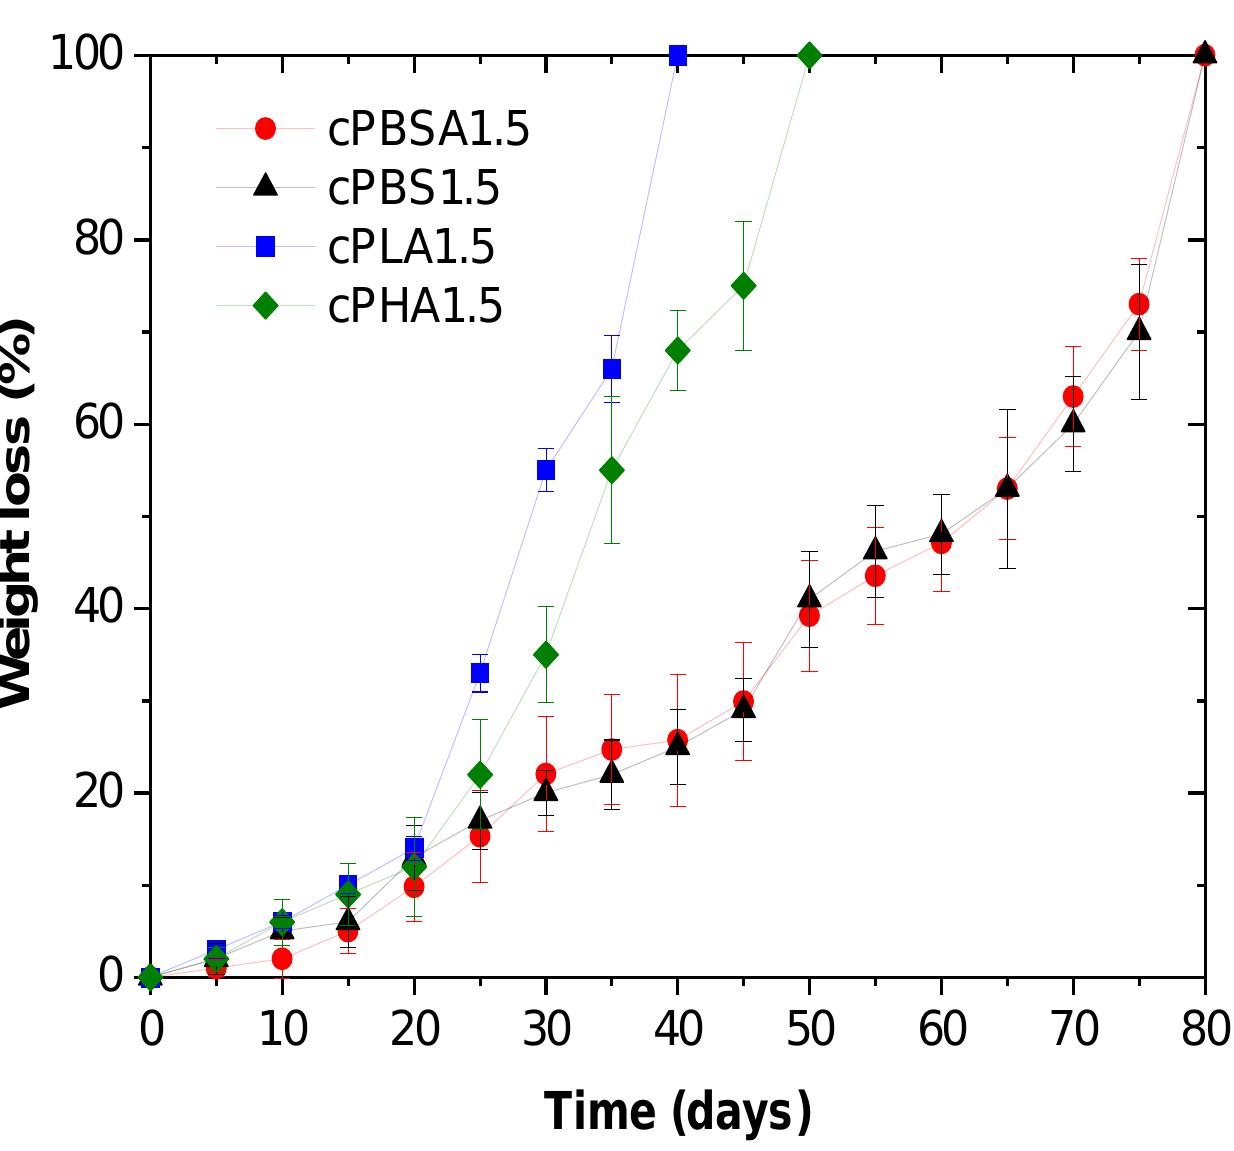
Figure 9. Cumulative weight loss of cPBSA1.5, cPBSA1.5, cPLA1.5, and cPHA1.5 laminates during biodegradation